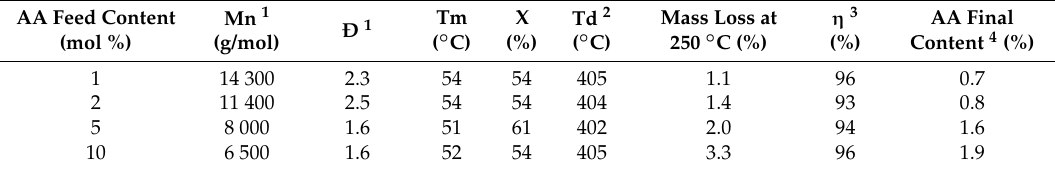
Table 2. Results obtained from the polymerization of CL with N -Boc cysteine hexyl ester. AA Feed Content (mol